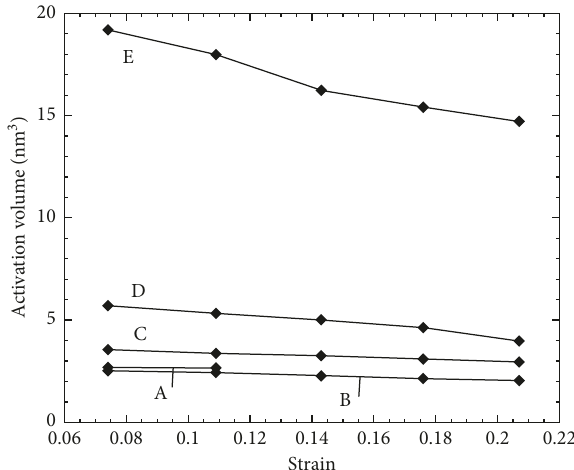
Figure 8: Activation volume V r measured by the stress relaxation test. A–E correspond to the letters in Figure